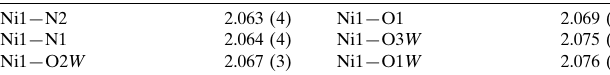
Selected bond lengths (A˚ ).